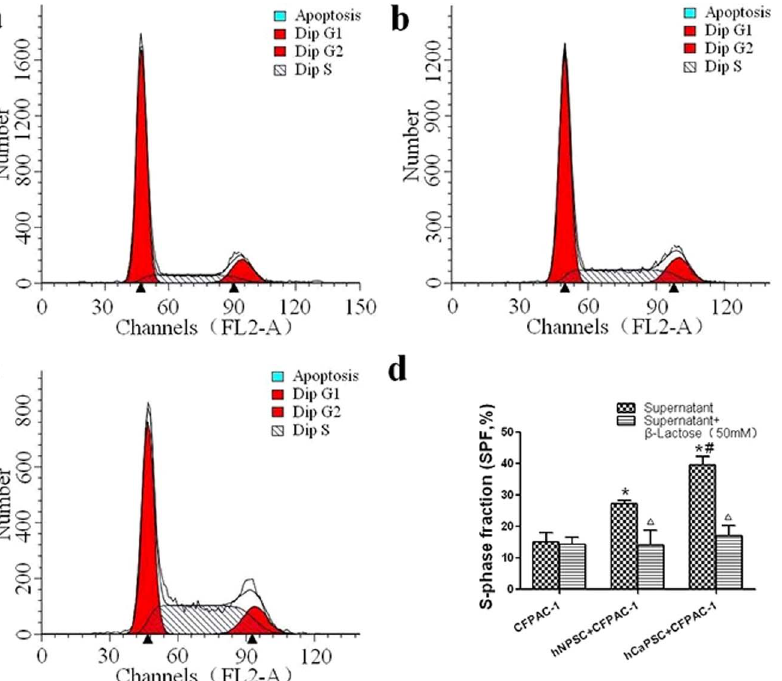
Figure 4. PSCs derived Galectin-1 promotes the proliferative activity (S-phase fraction) of CFPAC-1 cells. (a–c) Quantitative graphical representation of Apoptosis, G1, G2 and S cell population. Points, average of three independent experiments. a, CFPAC-1; b, CFPAC-1 + hNPSC; c, CFPAC-1 + hCaPSC. (d) A bar-graphical representation S-Phase Fraction cells in each group. * p , 0.01 vs . CFPAC-1, # p , 0.05 vs . hNPSC + CFPAC-1, g p . 0.05 vs . hNPSC + b